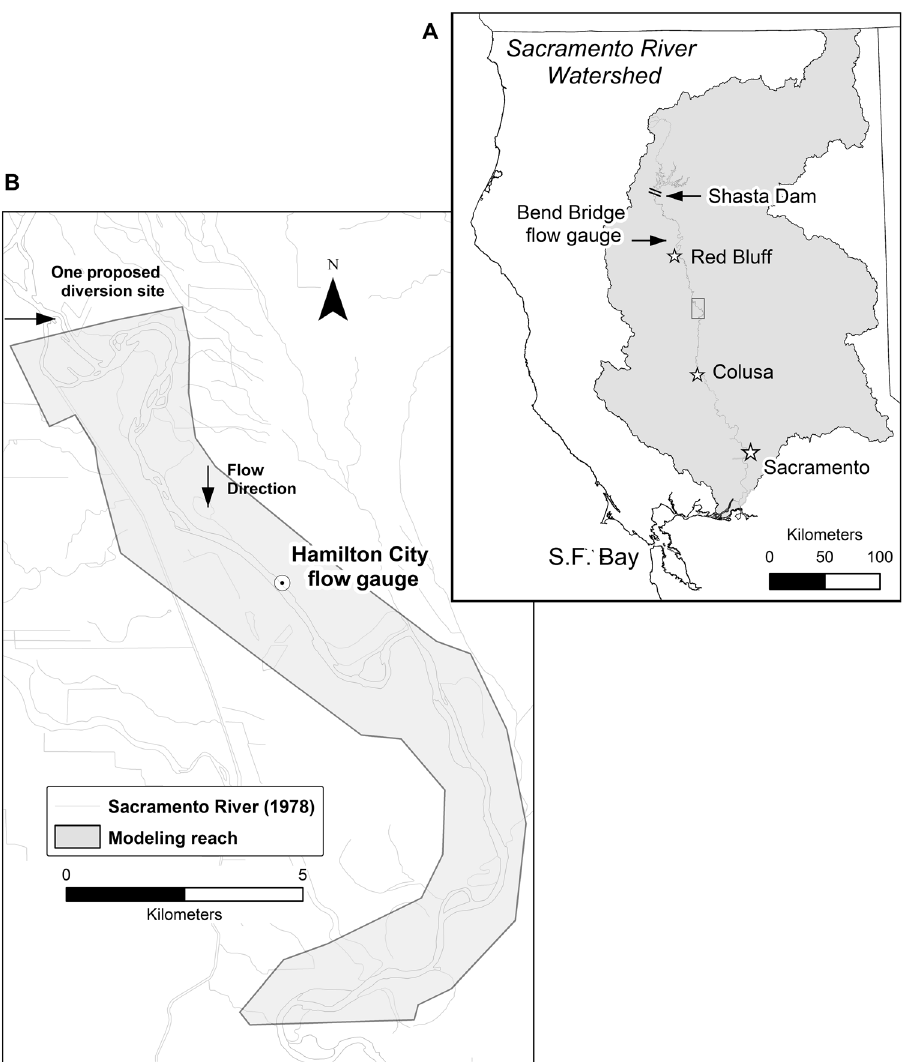
Figure 1. Study site map showing the modeled reach and the historic mapping extent. The meandering reach of the Sacramento River lies between the towns of Red Bluff and Colusa.